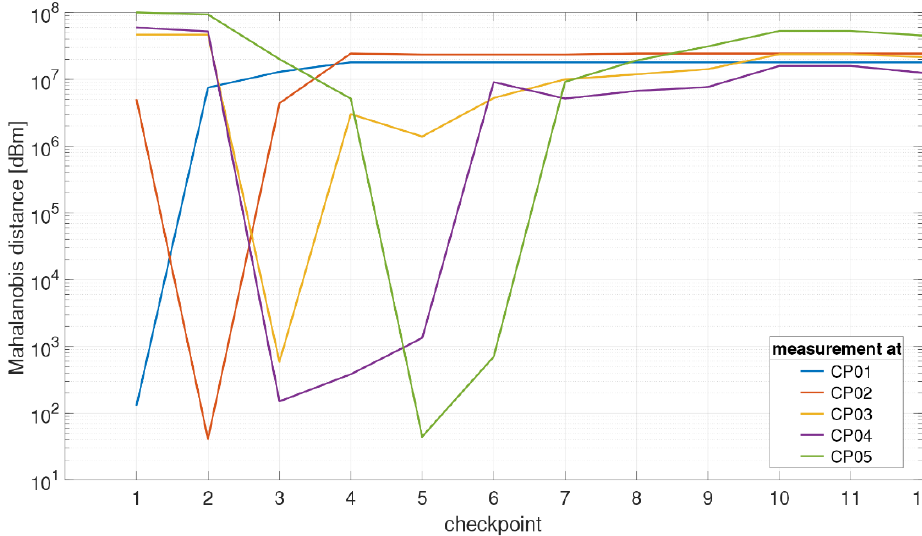
Figure 14. Positioning using the Mahalanobis distances at five different checkpoints (CP01 to CP05).